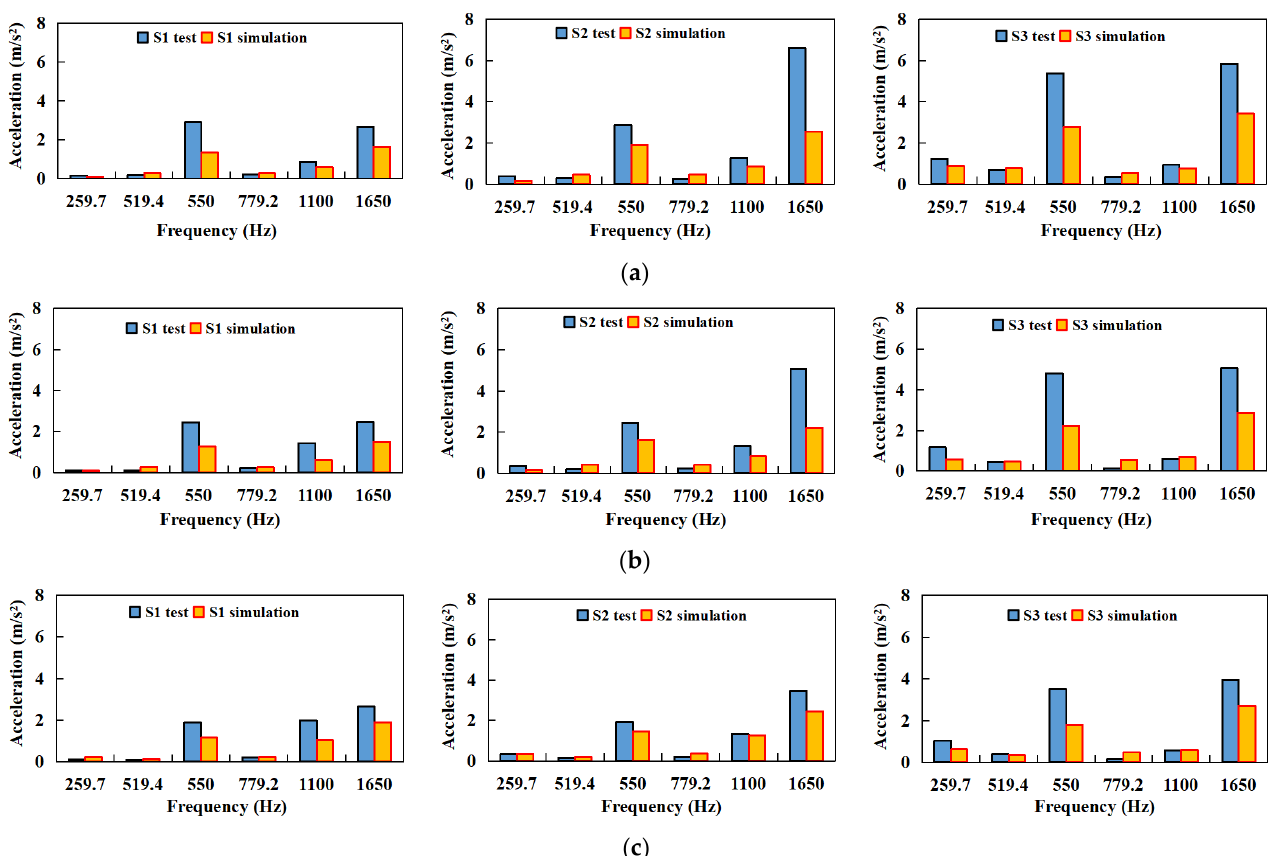
Figure 12. Comparison between simulation results and test data of housing vibration: ( a ) 3000 rpm 90 Nm input shaft, intermediate shaft, and output shaft accelerations; ( b ) 3000 rpm 75 Nm input shaft, intermediate shaft, and output shaft accelerations; ( c ) 3000 rpm 60 Nm input shaft, intermediate shaft, and output shaft accelerations.